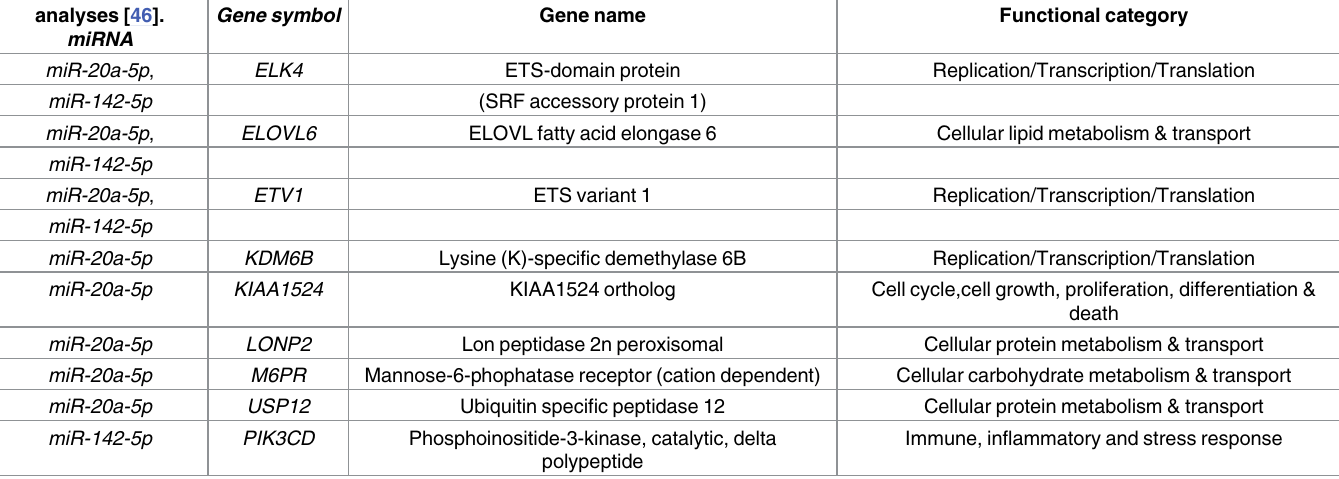
Table 3. Predicted targets of miR-20a-5p and miR-142-5p among DEG previously identified by microarrays. analyses [46]. Gene symbol Gene miRNA